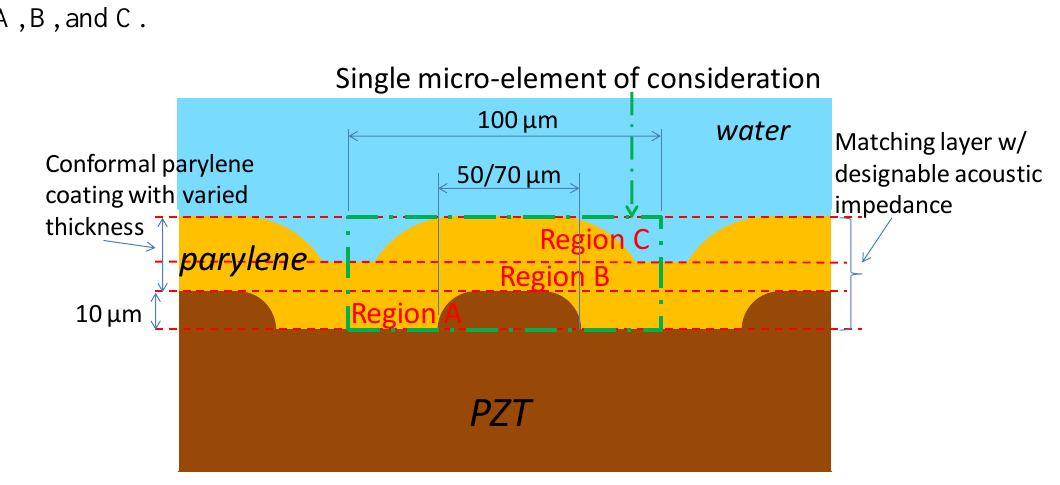
Figure 2. Illustration of the acoustic matching layer design containing the fabricated composite consisting of PZT micropillars and variable thickness Parylene to form Regions A, B, and